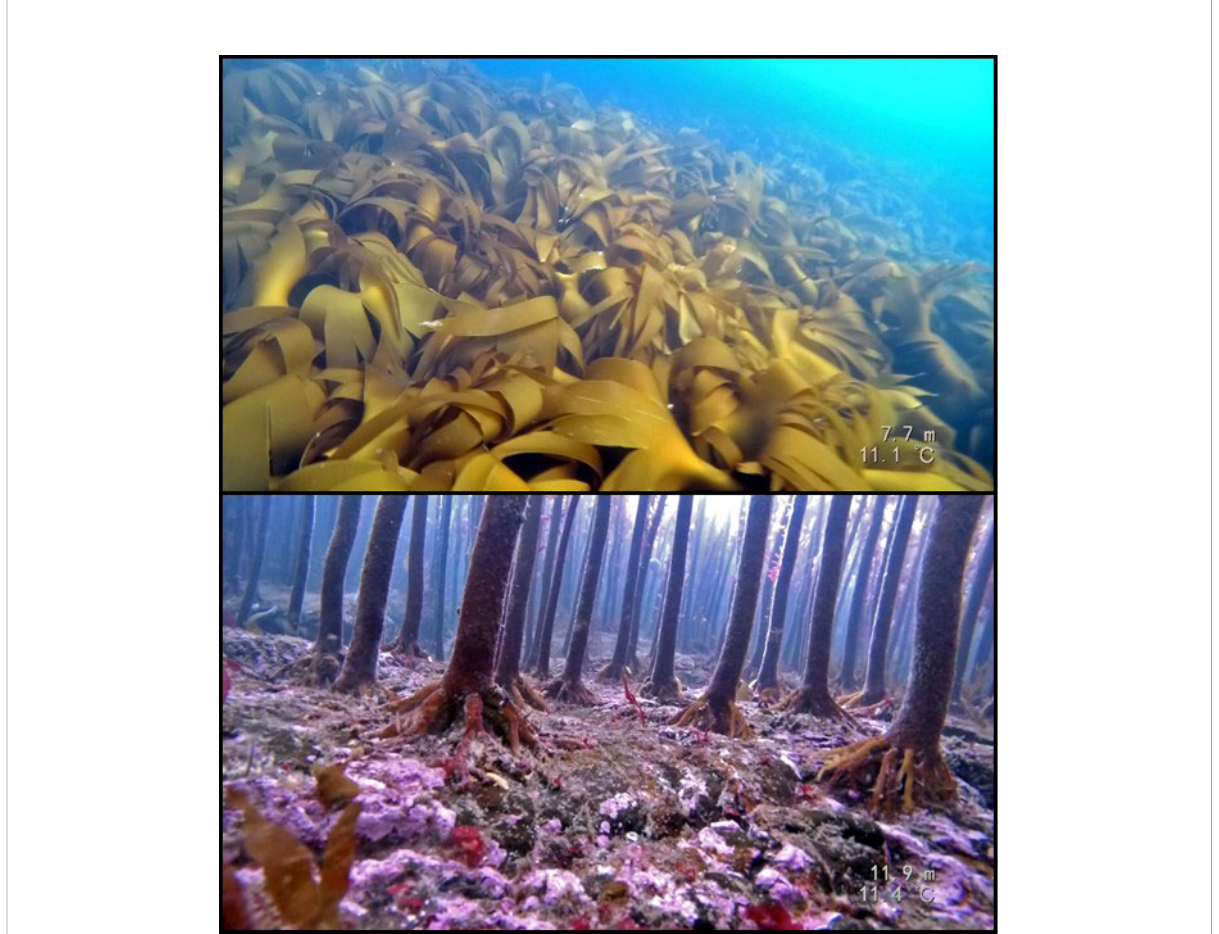
FIGURE 3 The canopy forming kelp Laminaria hyperborea viewed from above and beneath the lamina layer at the Helgeland area in Nordland.